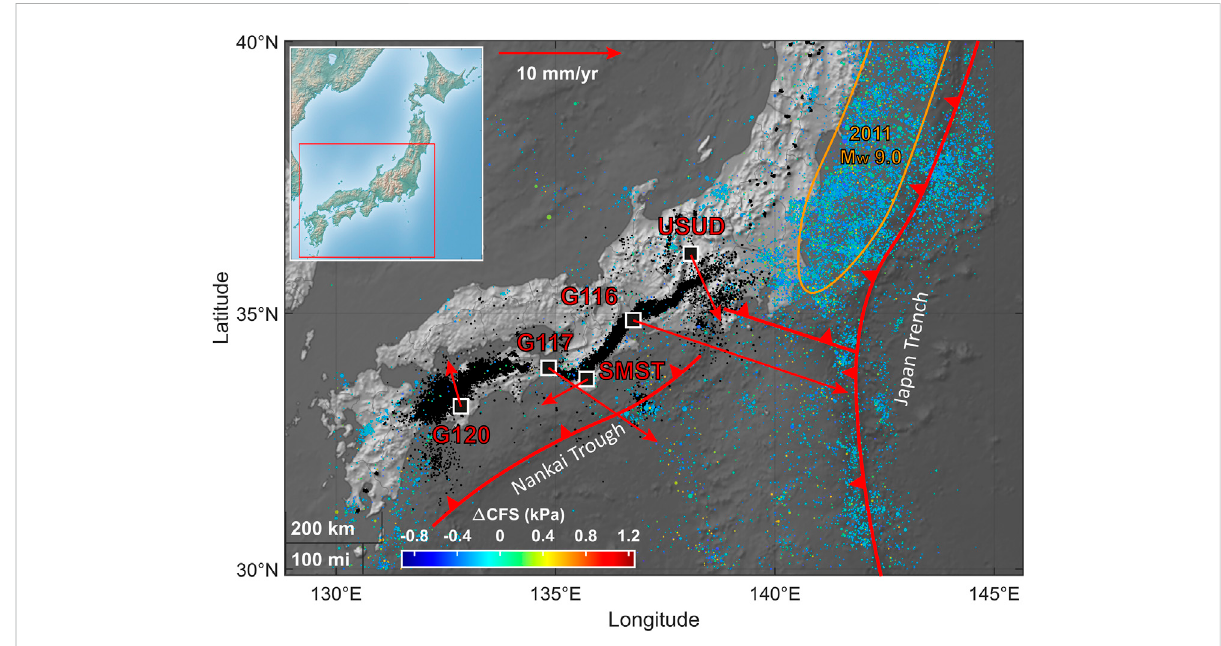
FIGURE 8 Map of seismicity in Southern Japan, USGS Catalog, 2005 − 2021, M L ≥ 4.0. Each earthquake is represented as a point whose color depends on the value of the Δ CFS at which it occurred, according to the color bar. Black points are LFEs [Idehara et al. (2014); Supino et al. (2020); Kurihara and Obara (2021)]. Five GNSS stations located along the strike with respect to the Nankai subduction zone are plotted on the map with the local vector velocity(redarrows)providedbyNGL[MIDAScomponents,Blewittetal.(2018)].Orangecontoursqualitativelyhighlightfaultpatchesbrokenby large earthquakes. Modi fi ed from Zaccagnino and Doglioni